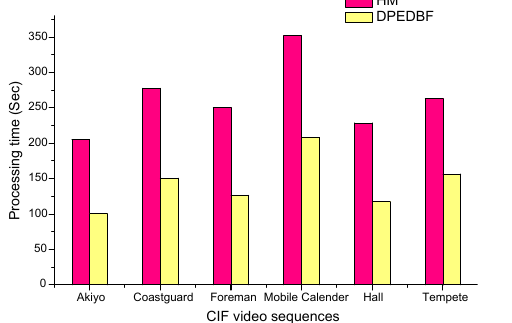
Figure 28. Comparison of processing time with HM for CIF video sequences using QP =